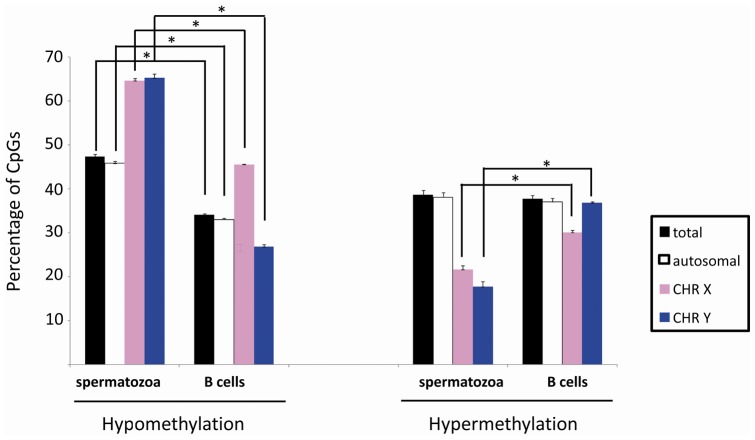
Bar graph illustrating the percentage of hypermethylated and
hypomethylated CpGs in swim-up sperm samples and B cells.The number of detected CpGs varies according to the data
extrapolation performed separately for each tested group: i) total
CpGs, ii) autosomal CpGs, iii) X chromosome-linked CpGs and iv) Y
chromosome-linked CpGs. * corresponds to p values <0.05 (the
whiskers show the SD; n = 7).